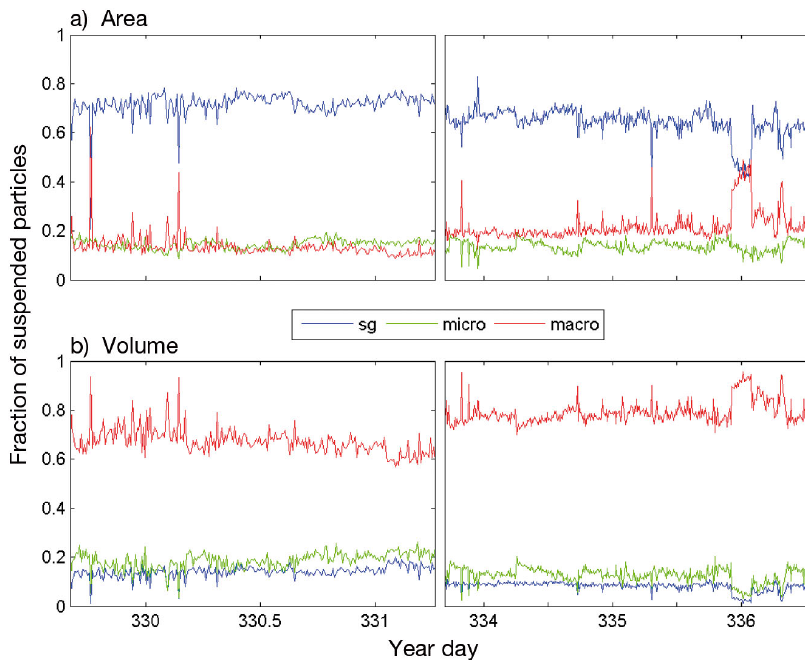
Fig. 4. Single grain (<33 µm), microfloc (between 33 and 133 µm), and macrofloc (>133 µm) fractions in suspension for (a) area and (b) volume based on the LISST 100X particle size distributions during 2 deployment periods (no. 1, left; no. 2, right)